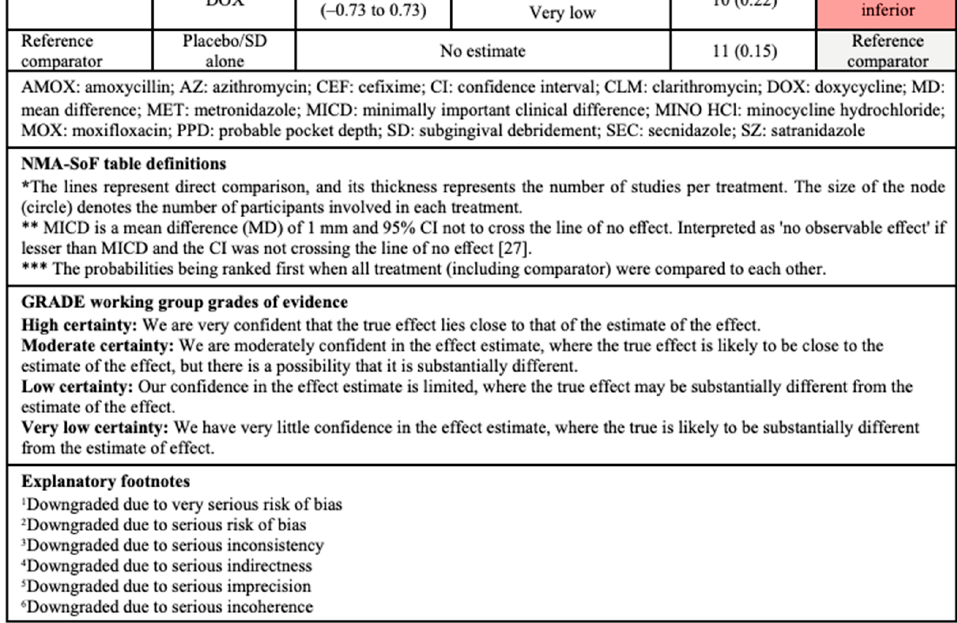
Figure 9. Summary of findings for short-term PPD reduction following the use of systemic antibiotics adjunctive to subgingival debridement.